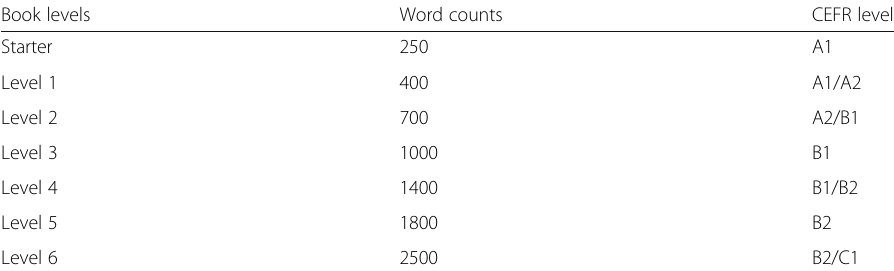
Table 2 Word counts and CEFR levels in the Oxford Bookworms Series Book